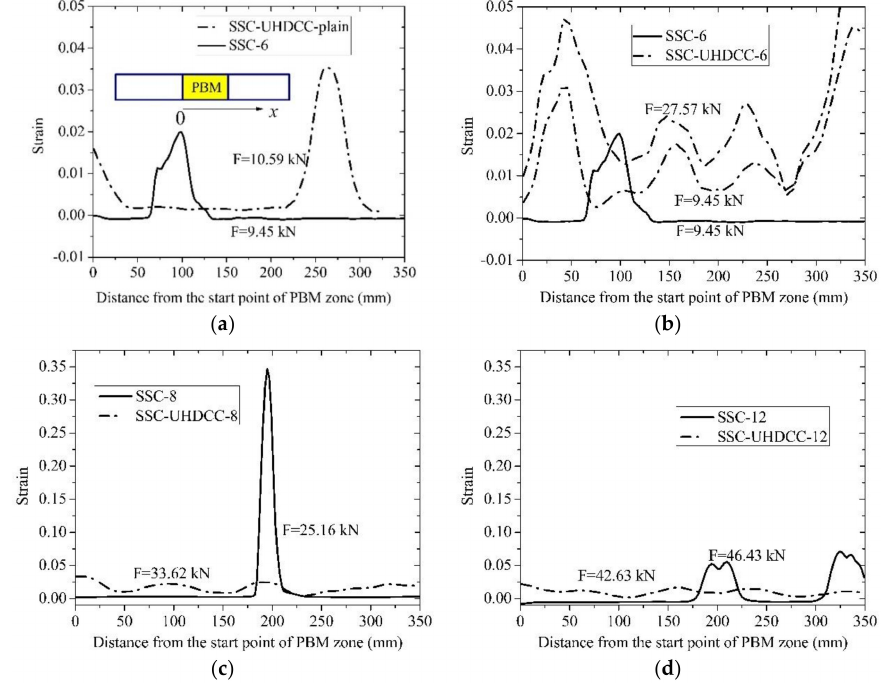
Figure 17. Strain distributions in x direction: ( a ) SSC-UHDCC-plain vs. SSC-6; ( b ) SSC-6 vs.